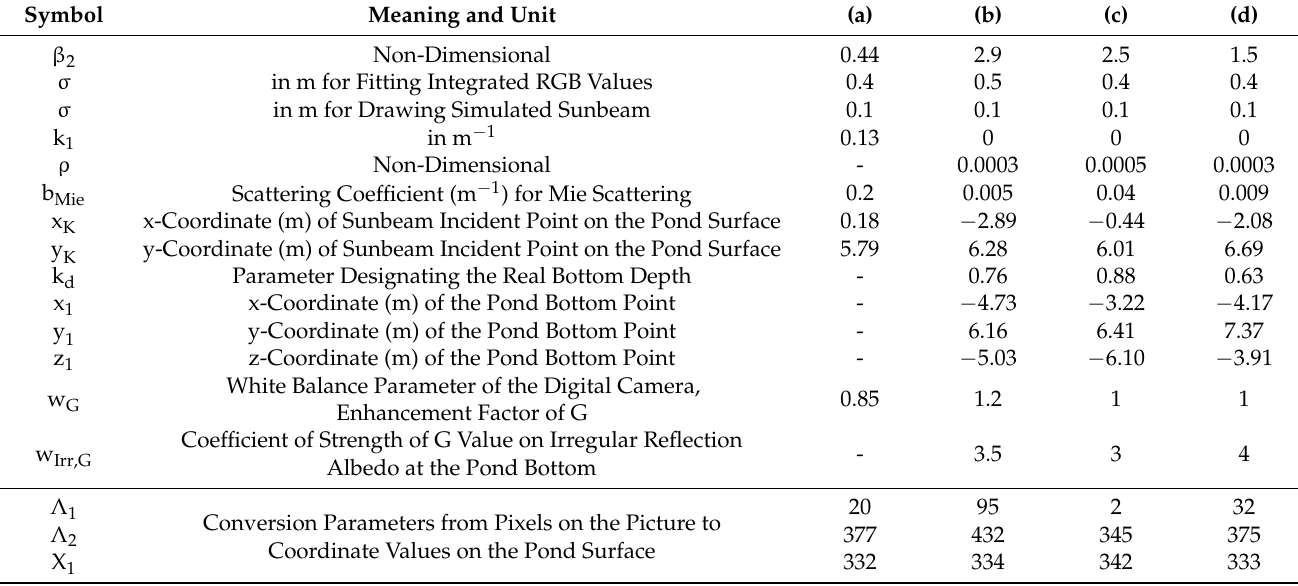
Common values of the parameters: ∆ x = 0.2 m, ∆ y = 0.2 m and ∆ z = 0.2 m, which were used in the fitting of the inte- grated RGB values. ∆ x = 0.1 m, ∆ y = 0.1 m and ∆ z = 0.1 m, which were used in simulations of the sunbeam